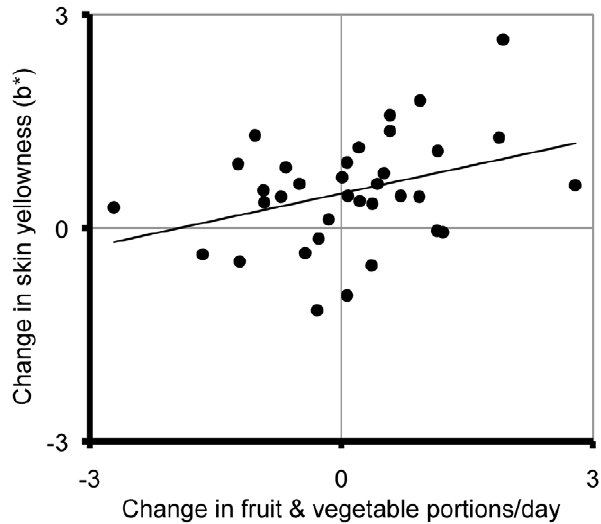
Figure 2. The relationship between six-week changes in fruit and vegetable intake and average skin redness (a*).